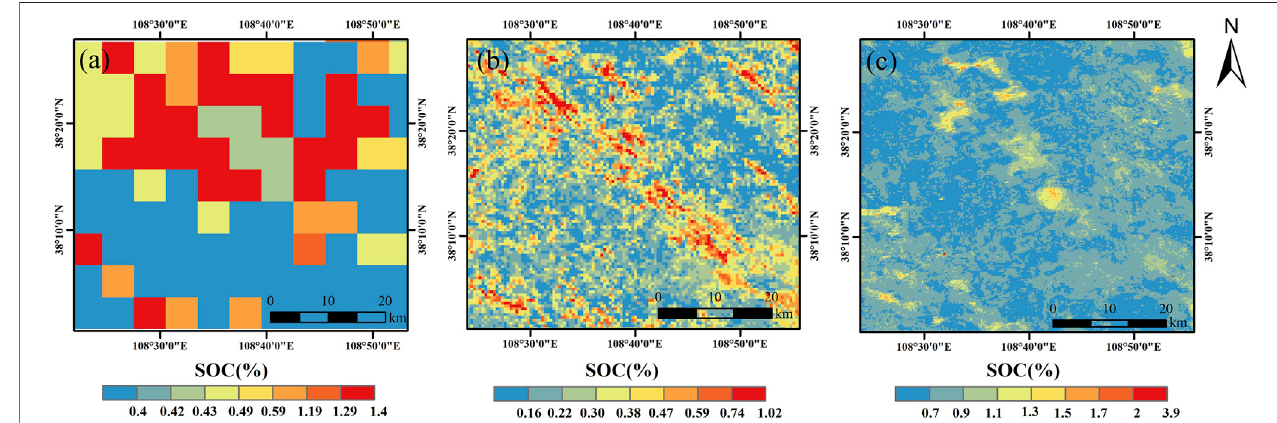
FIGURE 9 | Comparison of the best model output results with other soil organic carbon (SOC) maps from different data sources. (A) - harmonized world soil database, (B) – results of RF model A, (C) – soil grids database.